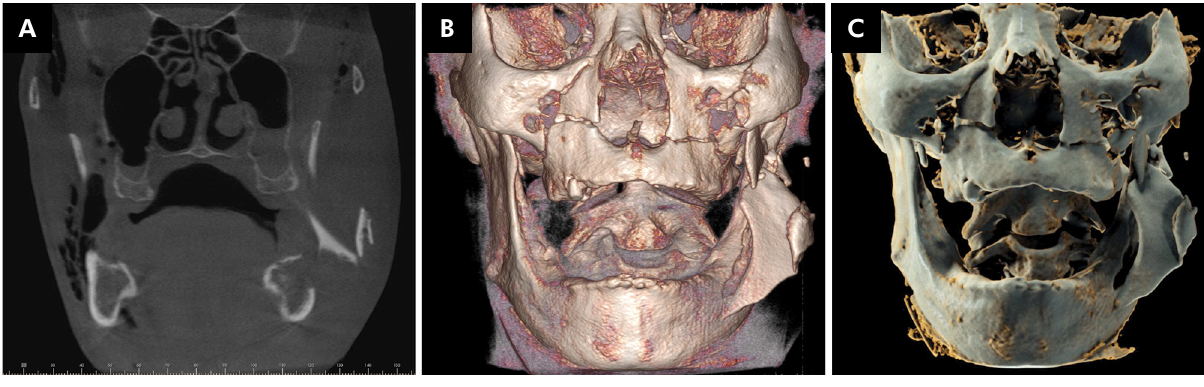
Figure 6. Case 5 (A-C). A 58-year-old man was referred to a private oral and maxillofacial radiology clinic (CROIF, Cuiabá, Brazil) for imaging studies to assess facial trauma after a serious motor-vehicle accident. Clinical examination revealed facial trauma and trismus. CBCT scan showed multiple facial fractures (A-C). The diagnosis was multiple facial fractures involving the mandible, maxilla, nasal fossa, floor of the orbit and zygomatic arch. The e-Vol DX software and its advanced 3D cinematic rendering tool (C) provided elements for a better analysis of fragment shapes and location and supported the decision of whether fragments should be kept or removed, as well as the planning of bone fragment repositioning during surgical facial